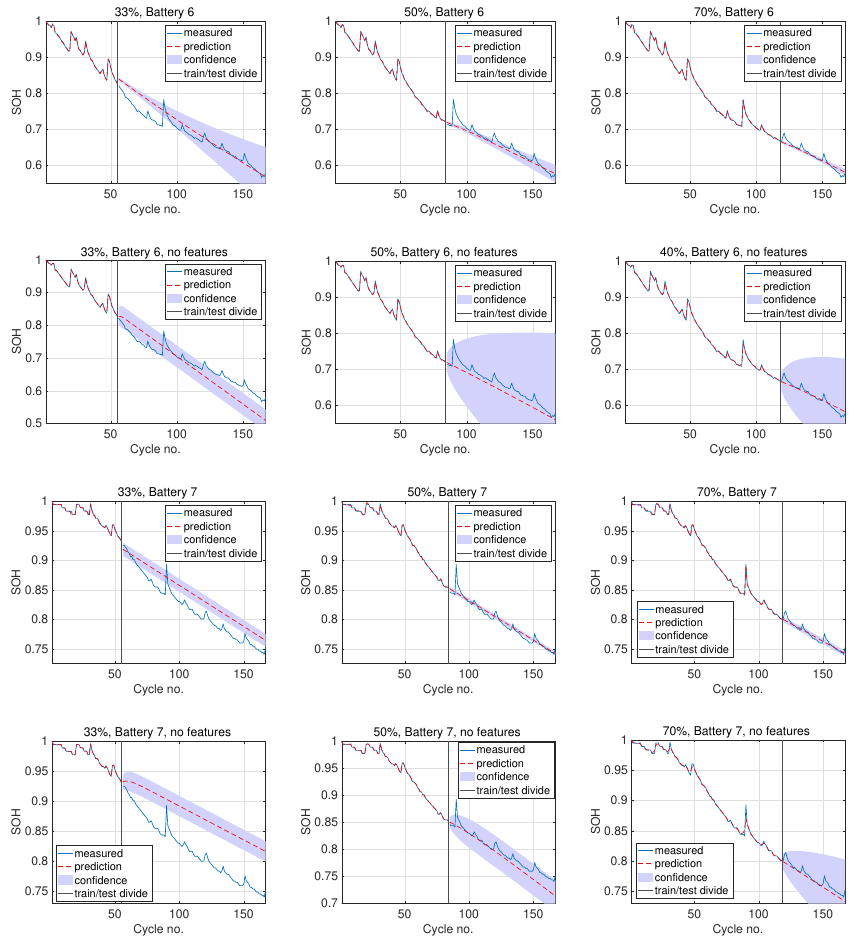
Figure 8. Predictions of the SOH based on a GP model with features x ( n ) for B0006 and B0007, at different training point numbers. The results for a GP model with input n (no features) are shown for